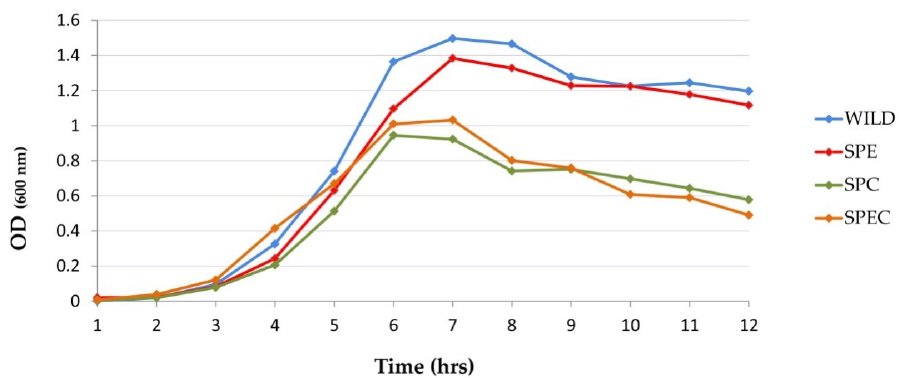
Figure 2. In vitro growth curve of S. pneumoniae constructed mutant strains as compared to the wild-type D39 strain in brain heart infusion (BHI) media as determined by the OD 600 values with time of inoculation. The statistical analysis of growth potential between the groups was performed using analysis of variance (ANOVA) followed by a post hoc Tukey’s test from three independent experiments. Abbreviations used: wild, S. pneumoniae D39 wild-type strain; SPE, S. pneumoniae D39 ( endA::aphA3 ) knockout strain; SPC, S. pneumoniae D39 ( cpsE::tetL ) knockout strain; SPEC, S. pneumoniae D39 ( cpsE::tetL ; endA::aphA3 ) double-knockout strain.